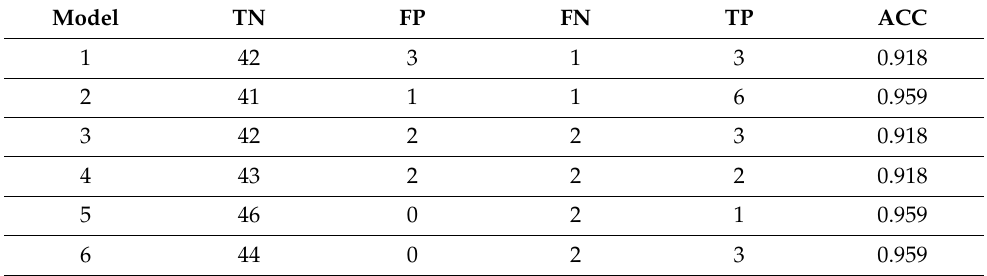
Table 6. Model validation results of set 1 for the slurry test with PLUG_SIGN as the output.